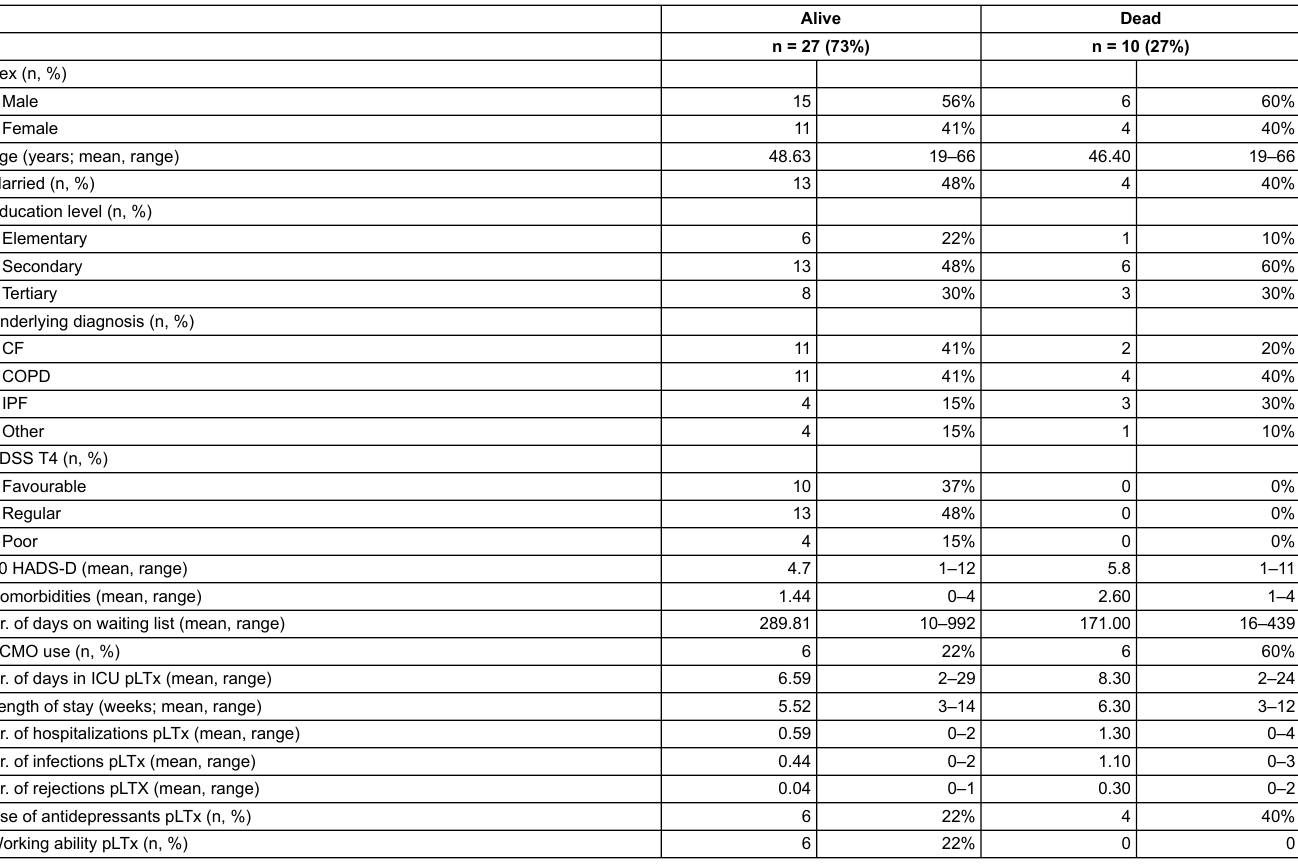
Table 1: Socio-demographic and medical characteristics.